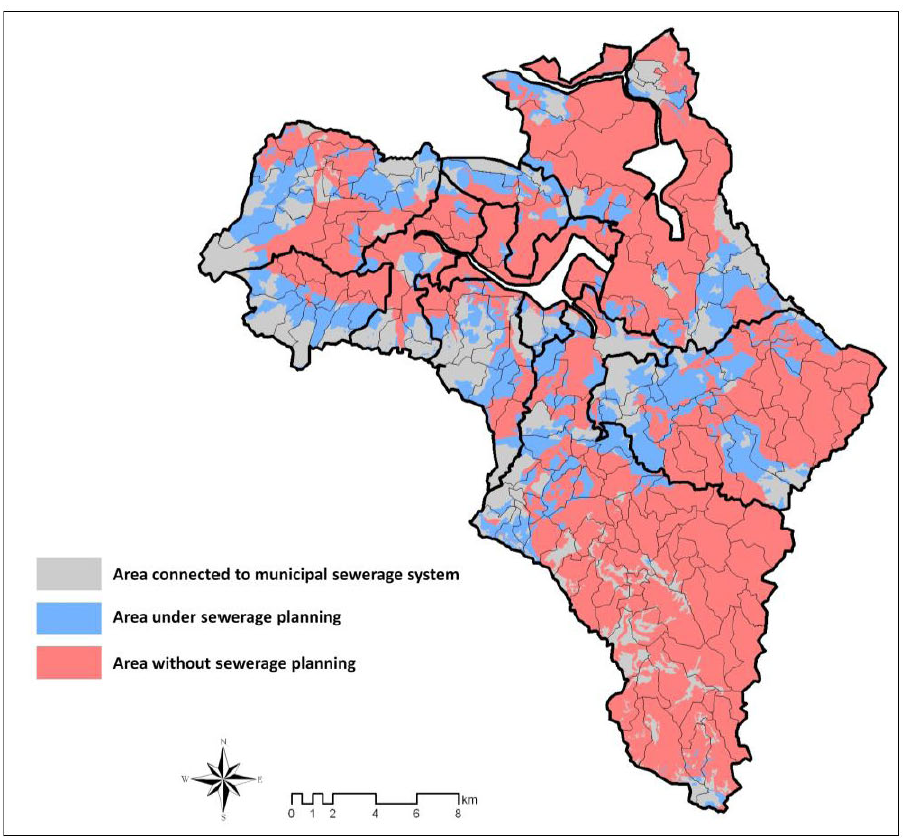
Figure 7. Sewerage planning in the Inba watershed. The research examines residential plots in areas where municipal sewerage systems are non-existent (red) or under-planning